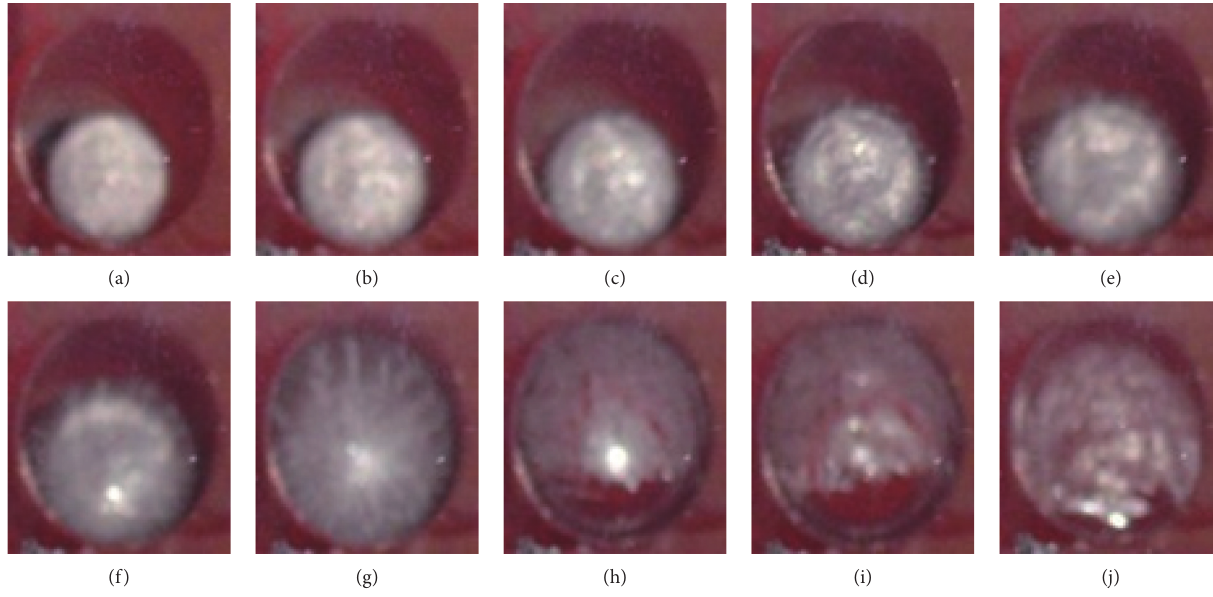
Figure 4: Foaming behavior in pipe A: (a) 255s, 678.8 ° C; (b) 270 s, 682.6 ° C; (c) 285s, 686.4 ° C; (d) 300s, 692.5 ° C; (e) 310s, 700.0 ° C; (f) 320s, 709.2 ° C; (g) 330s, 718.6 ° C; (h) 340s, 733.1 ° C; (i) 350s, 748.2 ° C; (j) 360s, 760.3 ° C.